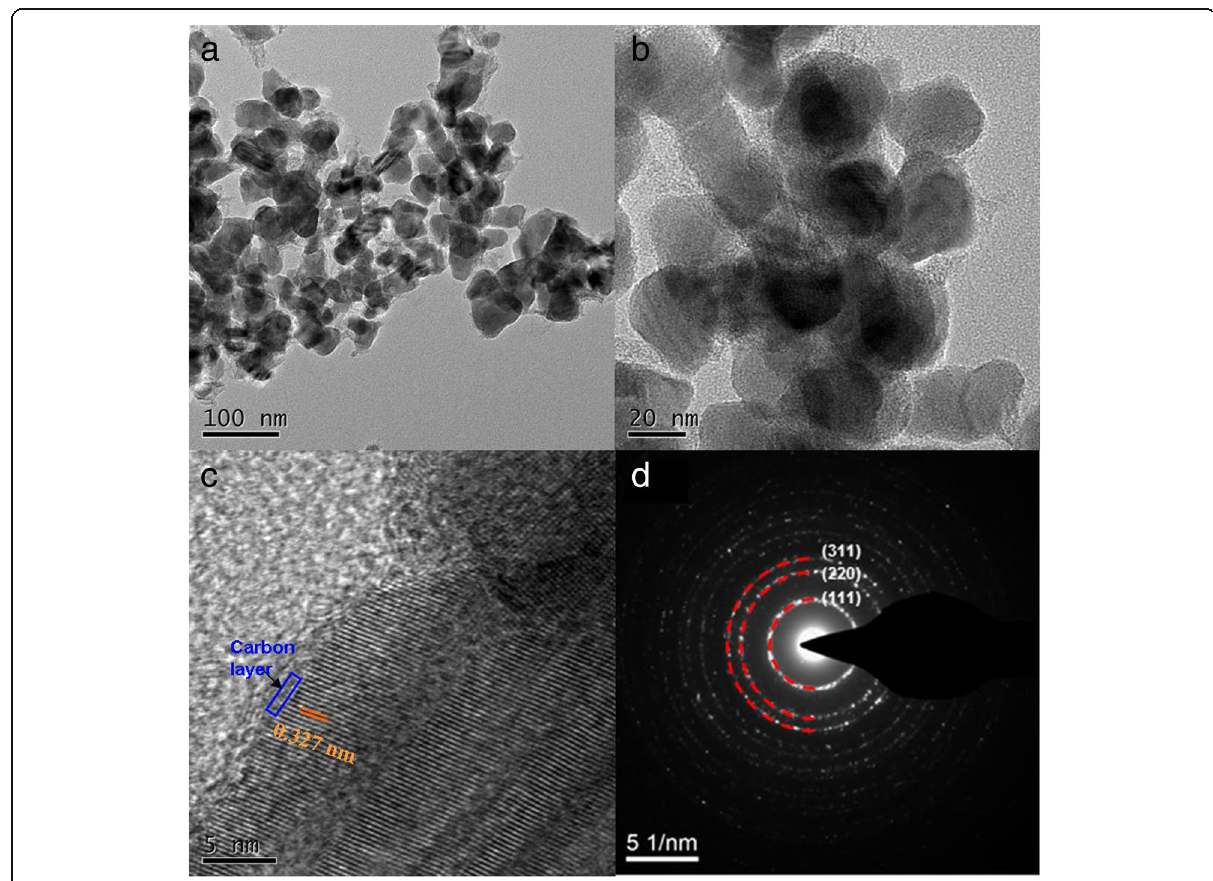
Fig. 4 a , b TEM images of ZnSe/NC-300. c HRTEM image of ZnSe/NC-300. d SAED image of